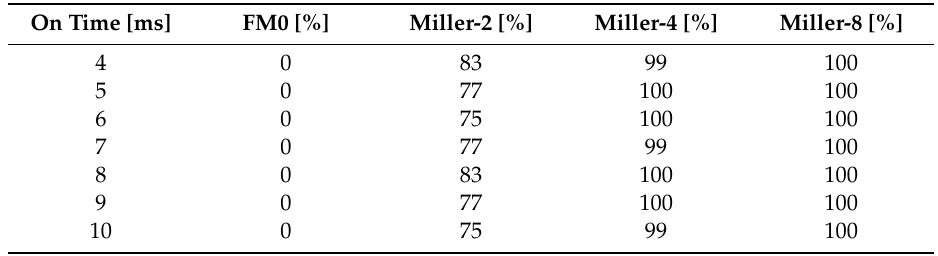
Table 2. Percentage of recorded readings for each encoding typology and activation time, using a Tari value of 12.5 µ s.